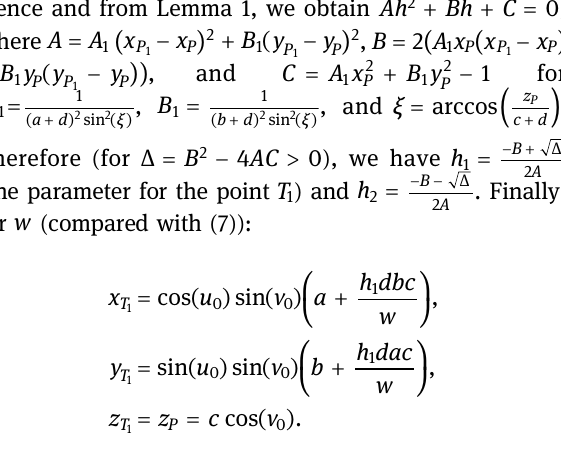
) , yellow line segments PP 1 and ( pink ) line segments PQ 1 . Figure 5 ( b ) presents a fragment of the ( orange ) ellipsoid S u v , ( ) , ( pink ) line seg - ( blue ) horizontal line segments PT 1 , and ments PQ 1 . The orthographic projections of the segments